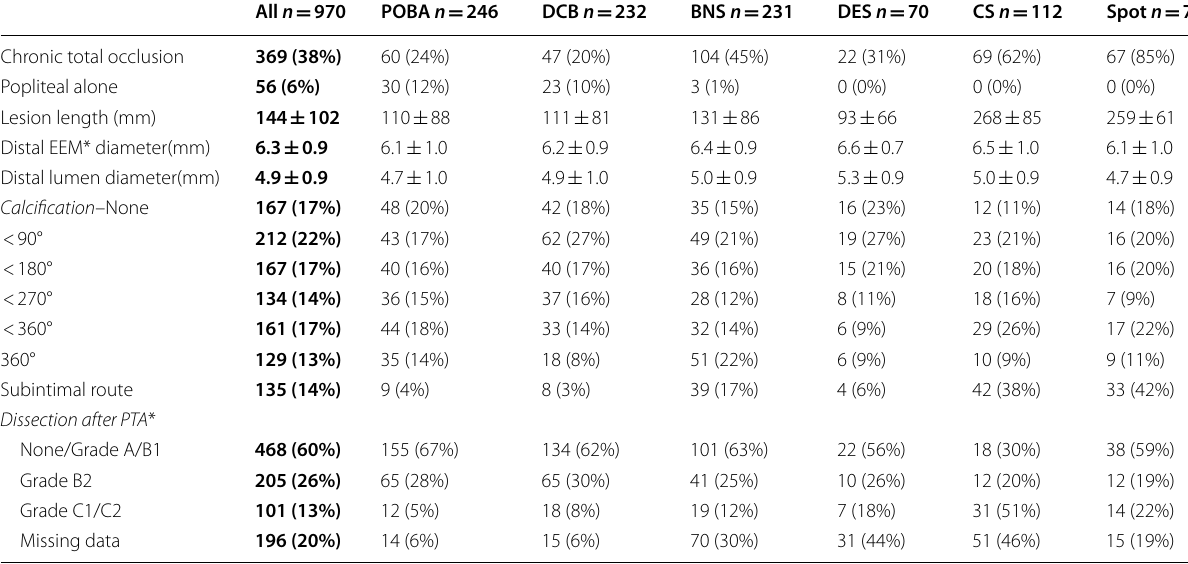
BNS Bare nitinol stent, CS Covered stent, DCB Drug-coated balloon, DES Drug-eluting stent, EEM External elastic membrane, POBA Plain old balloon angioplasty, PTA Percutaneous transluminal angioplasty